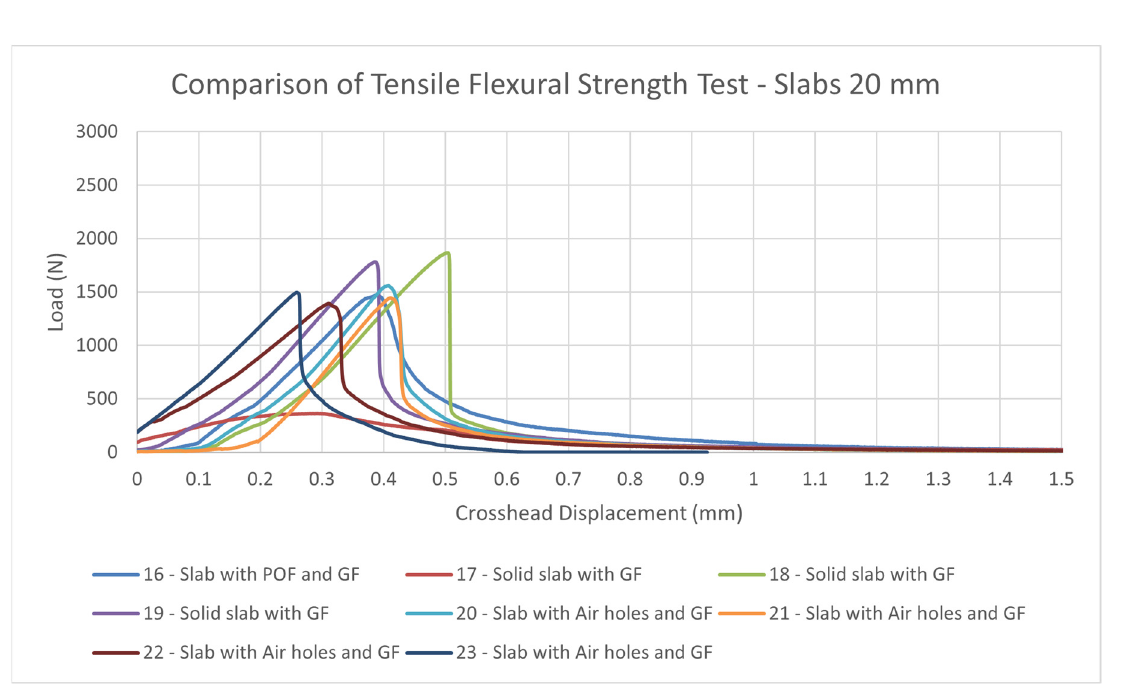
Figure 40. Comparison of tensile flexural strength test of slabs of thickness 20 mm.